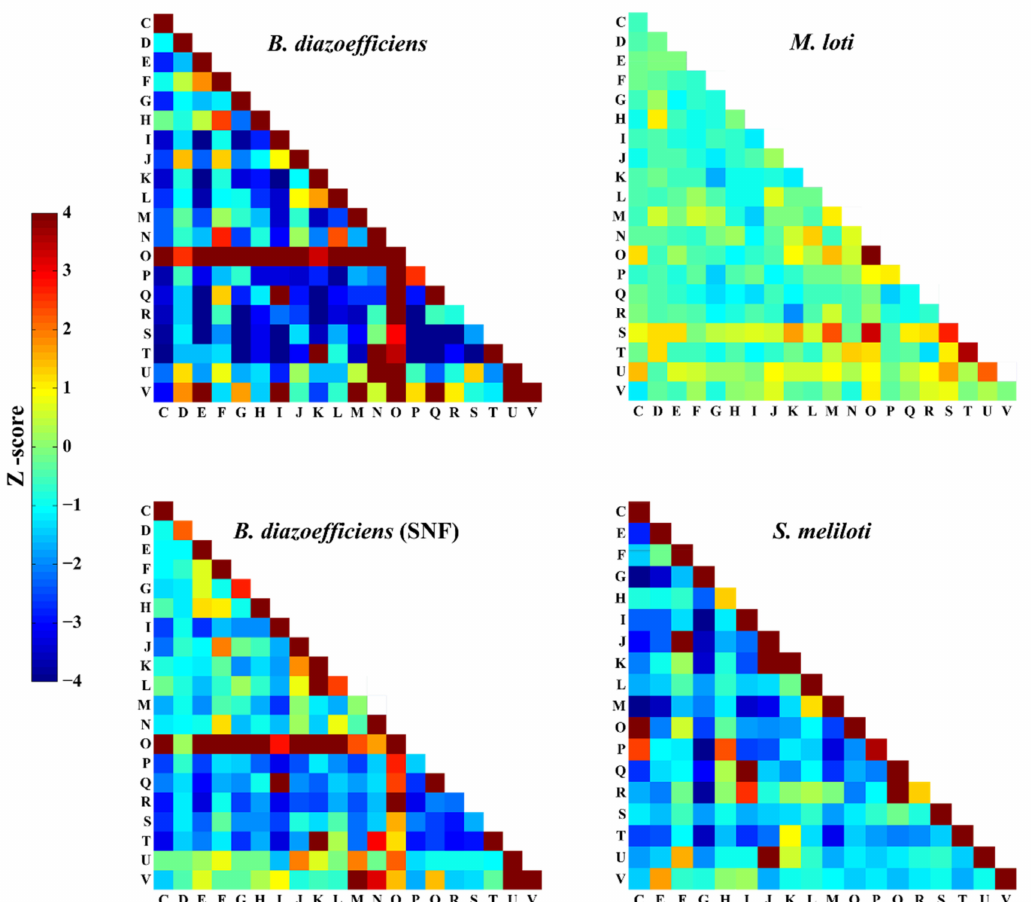
Figure 4. Enrichment in COG functional categories of PPIs for three organisms in different situations (the global PPI network: B. diazoefficiens USDA110, M. loti ; the PPI network for SNF: B. diazoefficiens USDA110 (SNF), S. meliloti ). The PPI numbers in COG categories were normalized by Z-score. Warmer color means higher